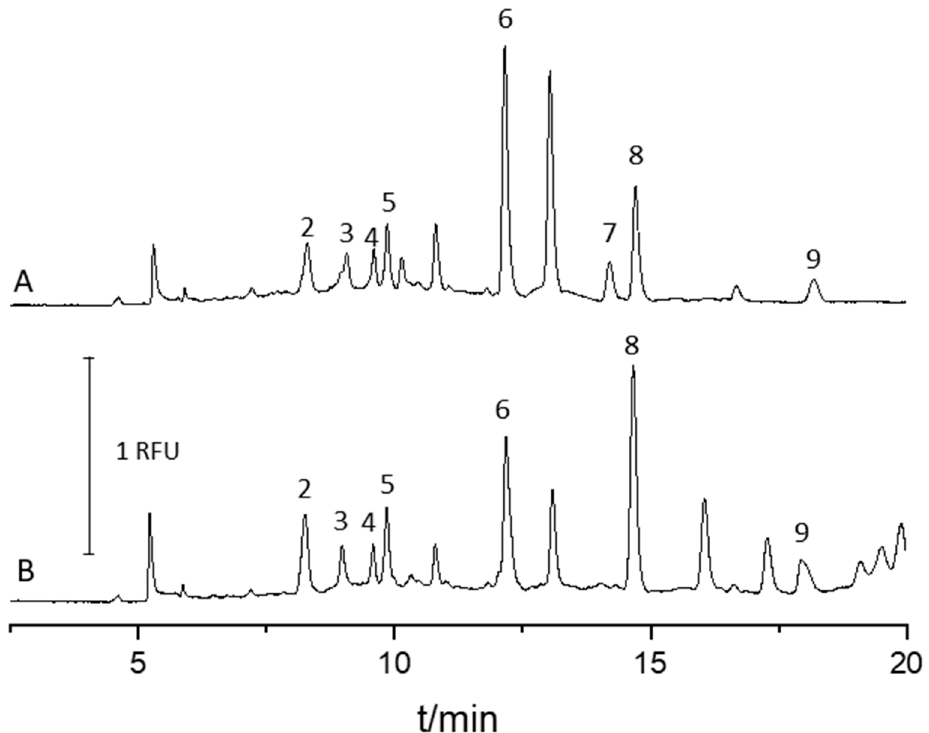
Figure 3. Separation of pterins from a healthy individual ( A ) and a cancer patient ( B ) urine samples. Experimental conditions and peak identity were the same as in Figure 2.